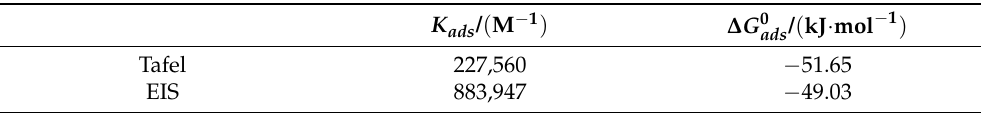
Figure 7. XPS analysis of corrosion products: ( a ) survey scan spectra; ( b ) narrow scan spectra of C1s, ( c ) N1s, ( d ) Cu2p, ( e ) Fe2p; ( f – h ) Adsorption isotherm model of Thy-1 corrosion inhibitor on Q235 carbon steel surface. Table 5. Adsorption thermodynamic parameters of Q235 carbon steel in 1 M HCl calculated under different test